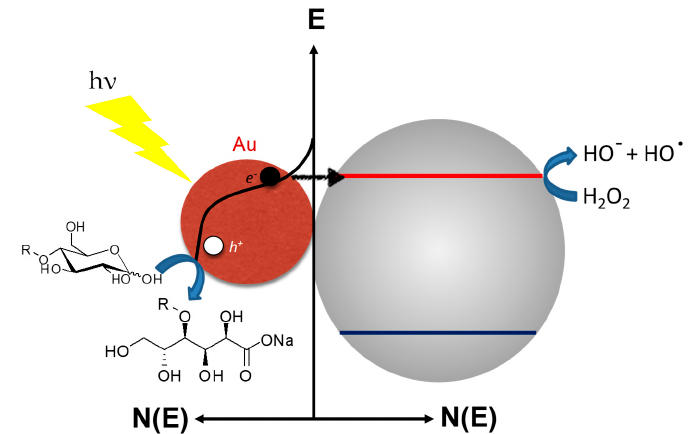
Figure 6. Proposed reaction mechanism of selective oxidation of free carbohydrates by using Au/MO x under standard A.M.1.5G conditions from Omri et al. [43].